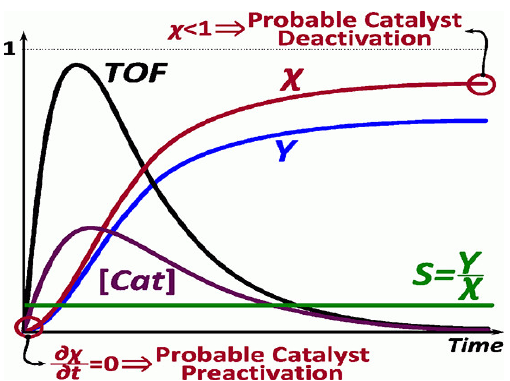
Figure 27. Model of active catalyst concentration and the turnover frequency (TOF). Reprinted with permission [120].